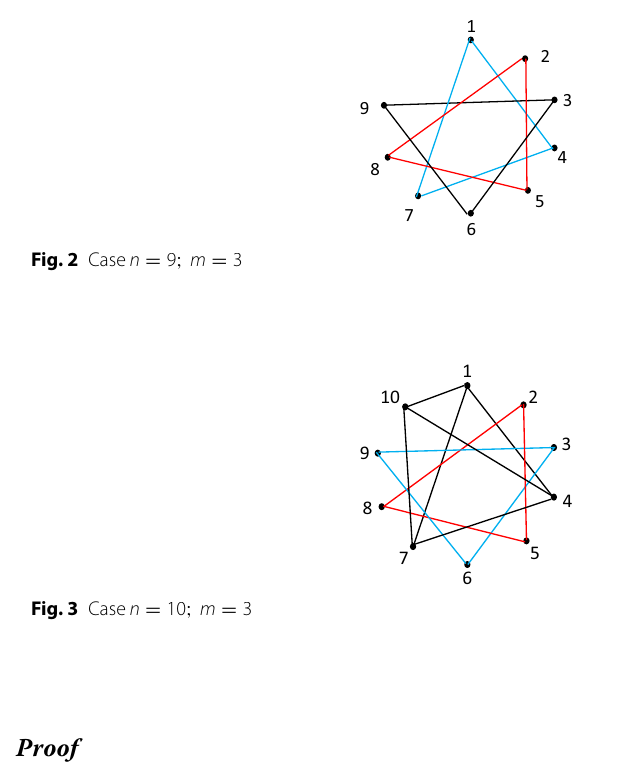
Fig. 2 Case n = 9 ; m = 3